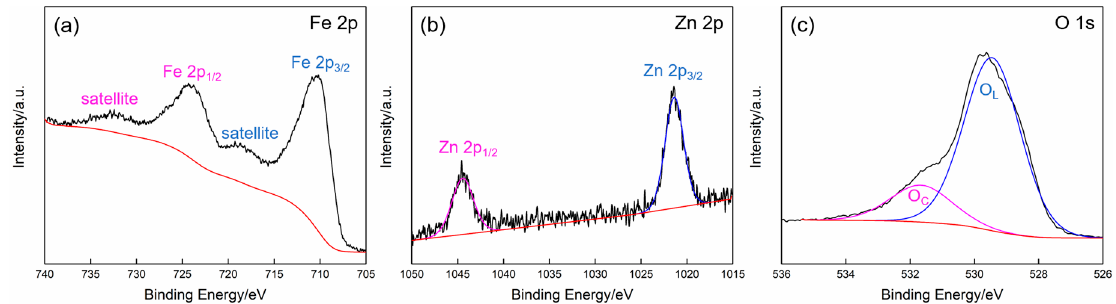
Figure 6. XPS spectra of 1% Zn-doped α -Fe 2 O 3 nanowires. ( a ) Fe 2p spectrum. ( b ) Zn 2p spectrum. ( c ) O 1s spectrum.